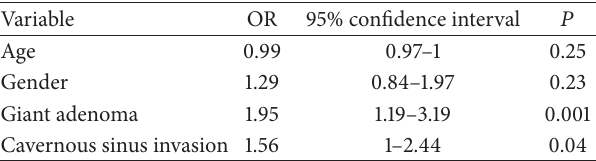
Table 2: Multivariate analysis of features potentially associated with tumor